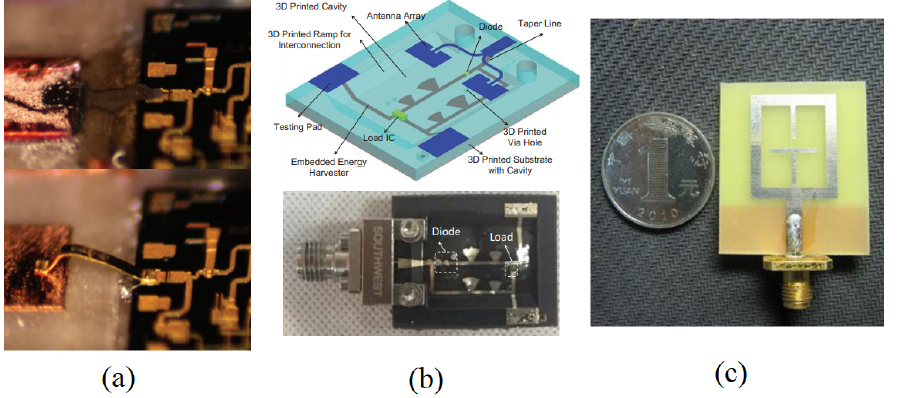
Figure 8. ( a ) Printed interconnect (above) and a ribbon-bond interconnect (below) (Reprinted with permission from [83]. Copyright 2020 IEEE); ( b ) the structure for the embedded-on-package 5G energy harvester (above) and printed device (below) (Reprinted with permission from [86]. Copyright 2019 IEEE); ( c ) Printed antenna for WLAN and 5G applications (Reprinted with permission from [84]. Copyright 2020